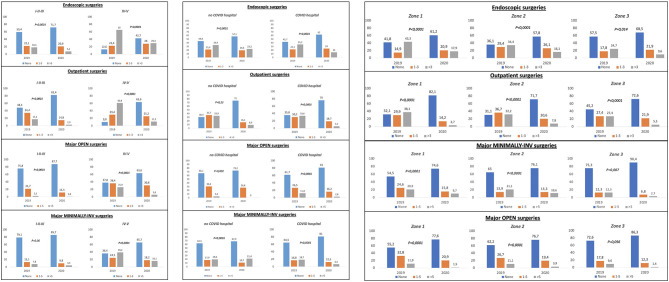
Histograms comparing surgical survey items (a: endoscopic, b: outpatient, c: major-open, and d: major-minimally invasive) between March 2020 (the highest outbreak level in Italy) and October or November 2019 (non-COVID-19 period) - stratification on the basis of the year of residency (I-II-III vs. IV-V), hospital kind (COVID or NO-COVID), geographical zones with different number of COVID-19 positive cases (regions of Italy were clustered in three major zones: zone 1 included regions with >10,000 cases, zone 2 included regions with between 2,000 and 10,000 cases, zone 3 included regions with <2,000 cases).